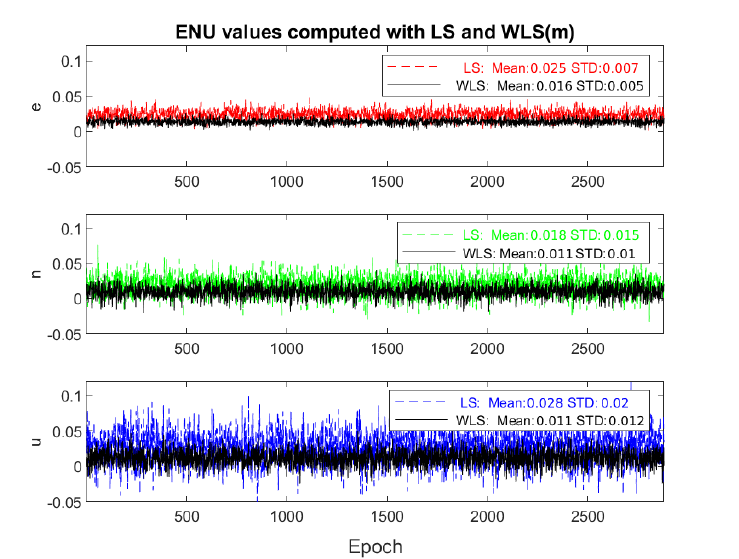
Figure 6. NEU values for the rover station for fixed least-squares and weighted least-squares solutions with their means and standard deviations for 3 − 9 January 2021.